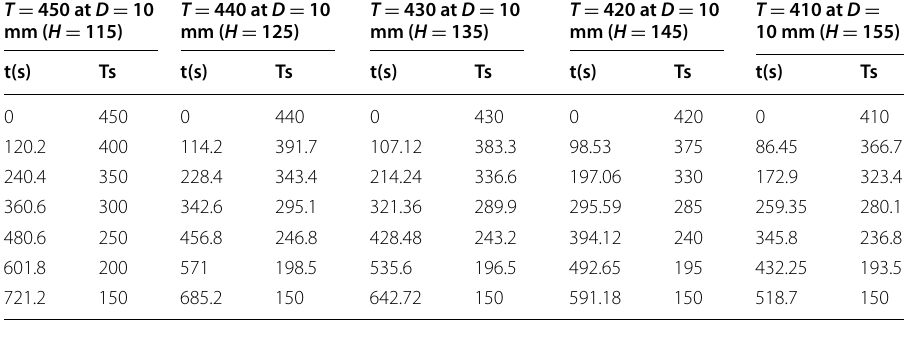
Table 3 150 ° C at D T 450 at D = mm ( H